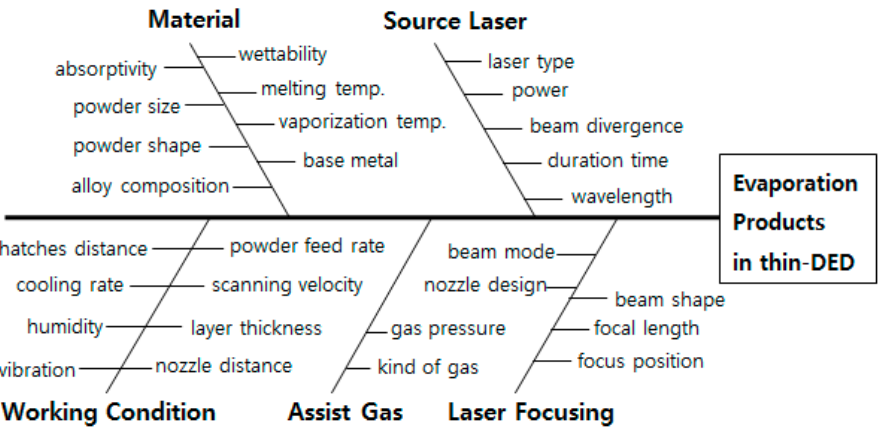
Figure 10. Ishikawa diagram showing the various parameters affecting the evaporation products in thin-DED (modified from Yeo’s Ishikawa diagram) [74].